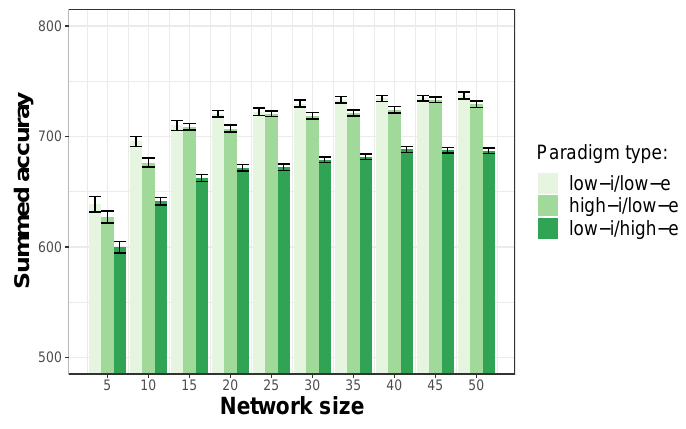
Figure 3: Summed accuracy over the 900 epochs of the networks trained on each of the three paradigm types across different sizes of the network. Error bars represent standard error. Note that the two low-i/high-e paradigms